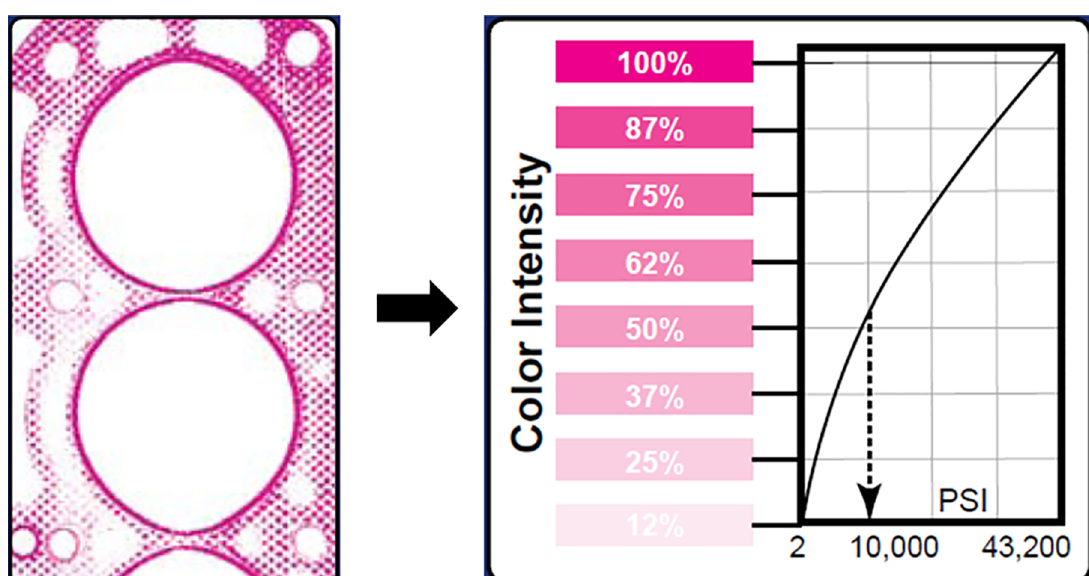
Figure 5. Pressure measurement through